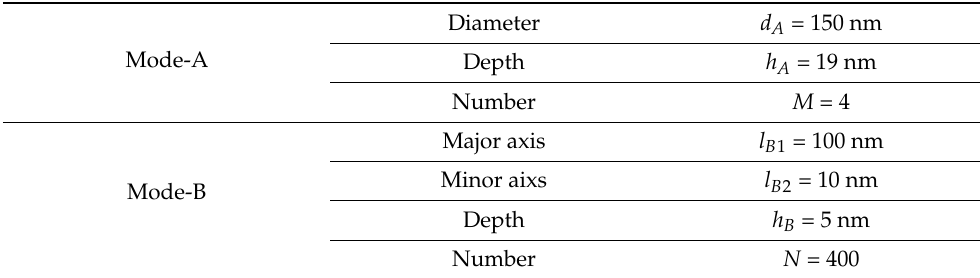
Figure 17. Removal pit shape and formed surface morphology in different modes: ( a ) four directions of mode − B removal pit and a random distribution, ( b ) mode − A removal pit and a random, distribution, ( c ) surface morphology using mode − A and mode − B per unit of time, ( d ) surface morphology using mode − A after 100 units of time, ( e ) surface morphology using mode − B after 100 units of time, and ( f ) surface morphology using mode − A and mode − B after 100 units of time. Table 3. Surface morphology generation simulation